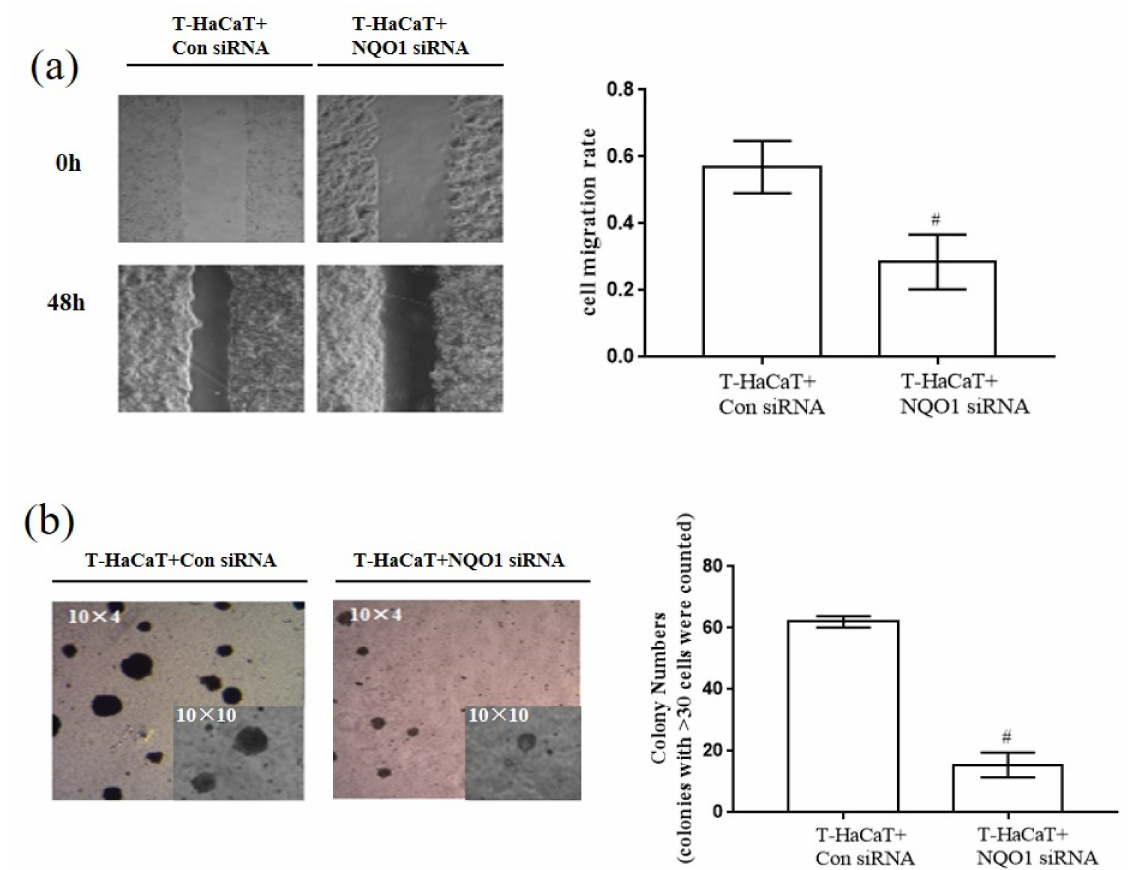
Figure 6. The cell migration rate and the colony number in T-HaCaT cells after transfection with NQO1 siRNA. ( a ) Wound-healing assay (magnification factor: 10 × 4) and the rate of migration. ( b ) Colony formation assay and colony numbers. Error bars are the mean ± SD ( n = 3). # Compared with control siRNA cells, p <